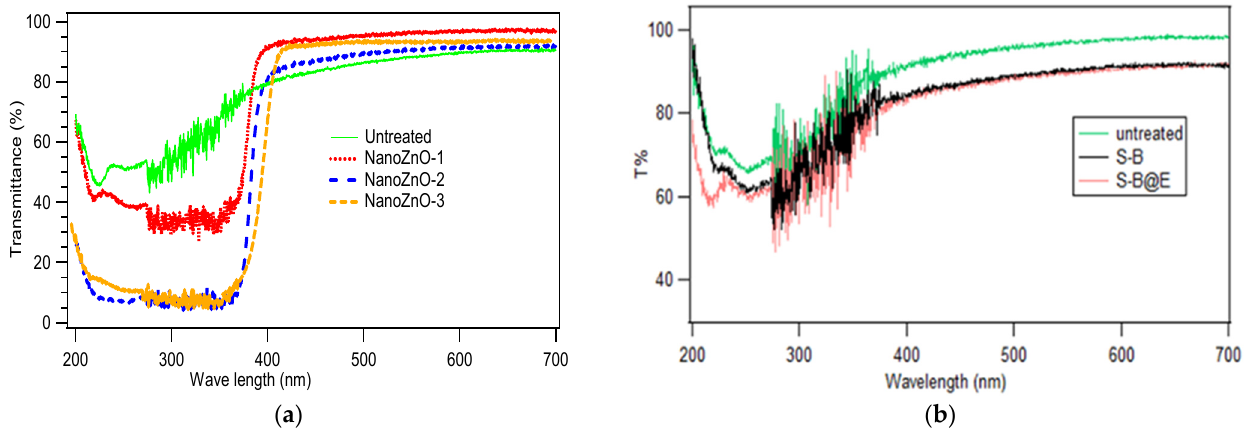
Figure 4. UV transmittance curve of ( a ) untreated fabric and different ZnO nano-coated fabric; ( b ) untreated fabric, only binder-treated (S-B) fabric, and binder with emulsifier-treated fabric (S-B@E). Table 1. Average UV transmittance (%) of different wavelengths with UPF range.